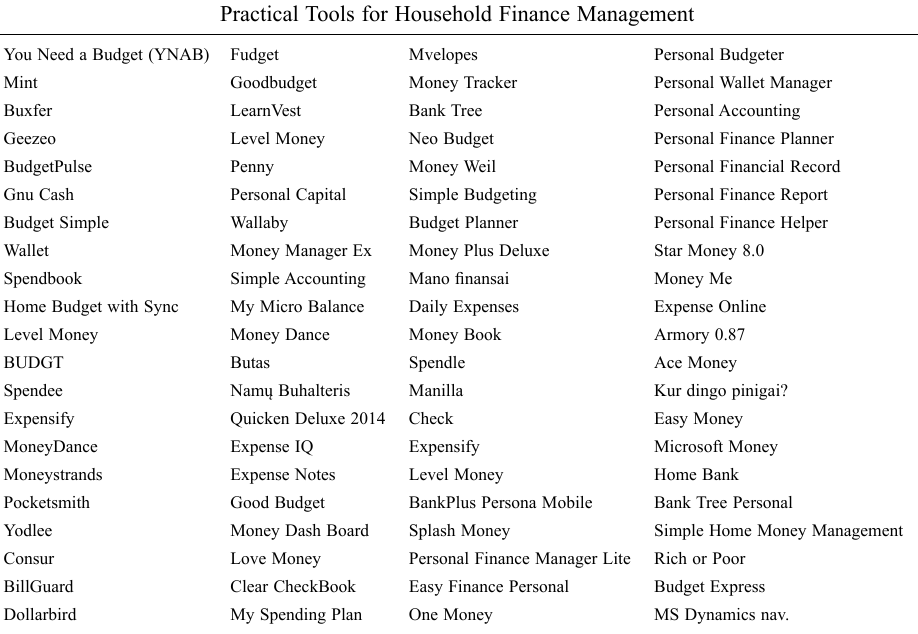
Table 1. Most popular budgeting tools for households Practical Tools for Household Finance Management